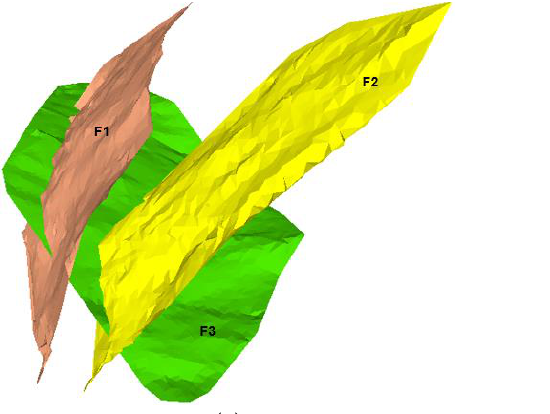
10 of 19 Figure 11. Example of triangulation of intersecting surface. ( a ) shows two intersecting planes. ( b ) shows two intersecting surfaces with geometrical topology consistency. 3.2.4. Judging the Truncated Part When the relationships between the intersecting faults are defined, the minor fault is appropriately truncated. Taking the intersection line and its extension as the boundary, the minor fault can be divided into two parts: the upper and lower parts, and the truncated part is separated from the fault model. Usually, the smaller spread part is truncated. There are some labels: The upper part is truncated as ‘up’; the lower part is truncated as ‘down’;